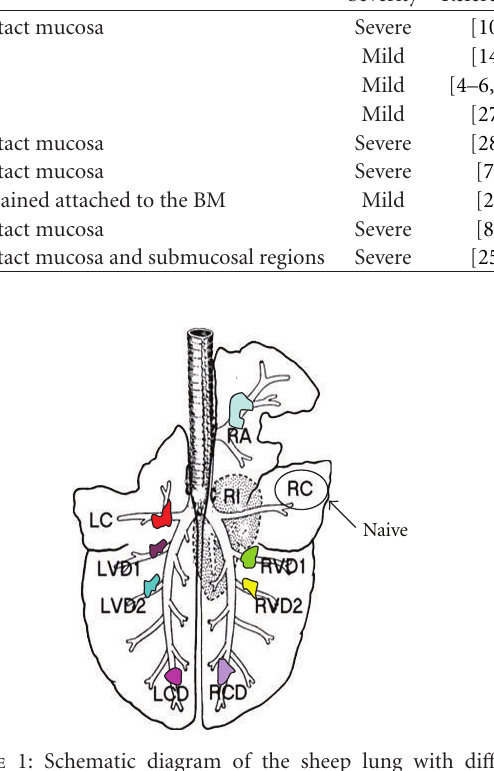
Table 1: Animal models of mechanical injury. Variation in the severity of injury can be expected to influence the timing of the repair process. Models